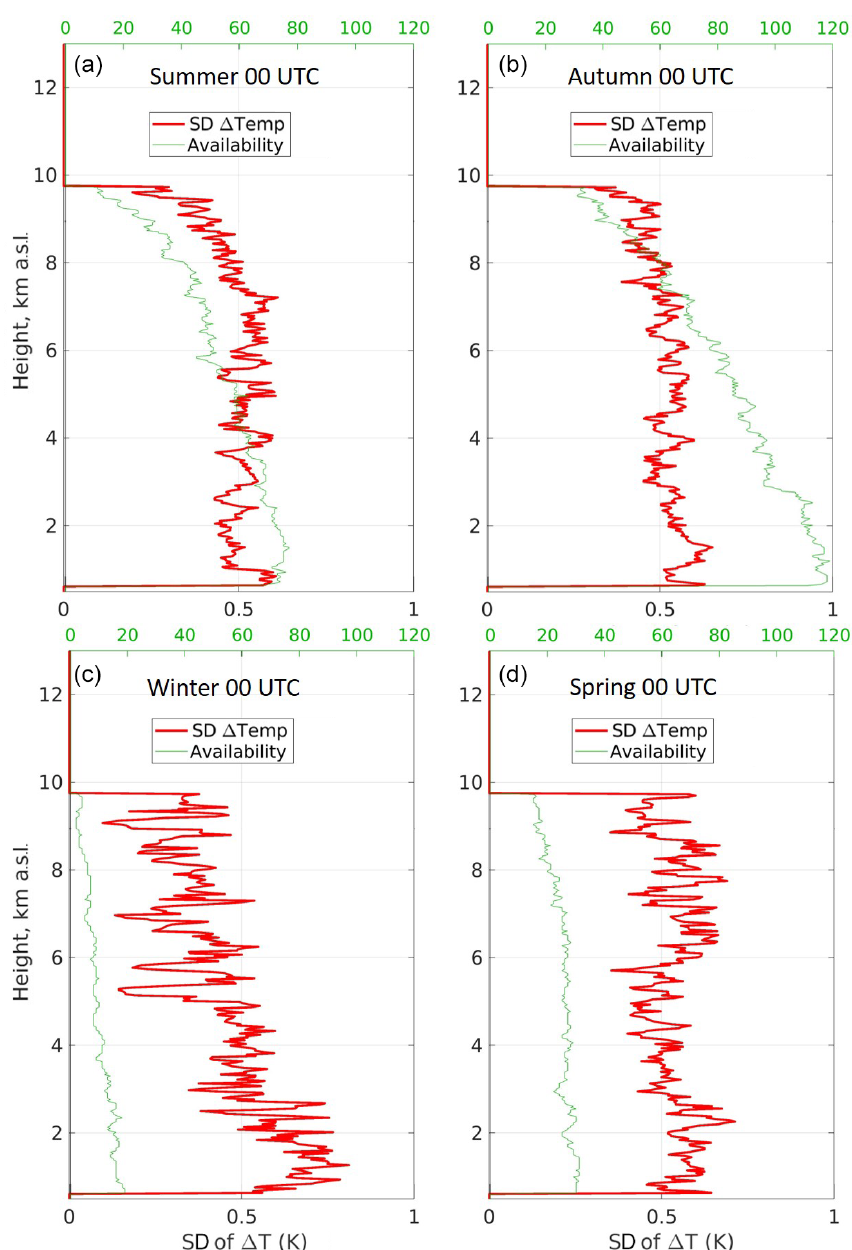
Figure 16. Seasonal nighttime standard deviation (SD) of (cid:49)T over the period July 2017–December 2018. The vertical profiles of standard deviation (thick red) are calculated over the altitude-decreasing number of (cid:49)T points (thin green). Based on the definition of seasons provided in the text, in clockwise order starting form the upper-left corner, panel (a) shows the summer data, panel (b) shows the autumn data, panel (c) shows the winter data and panel (d) shows the spring